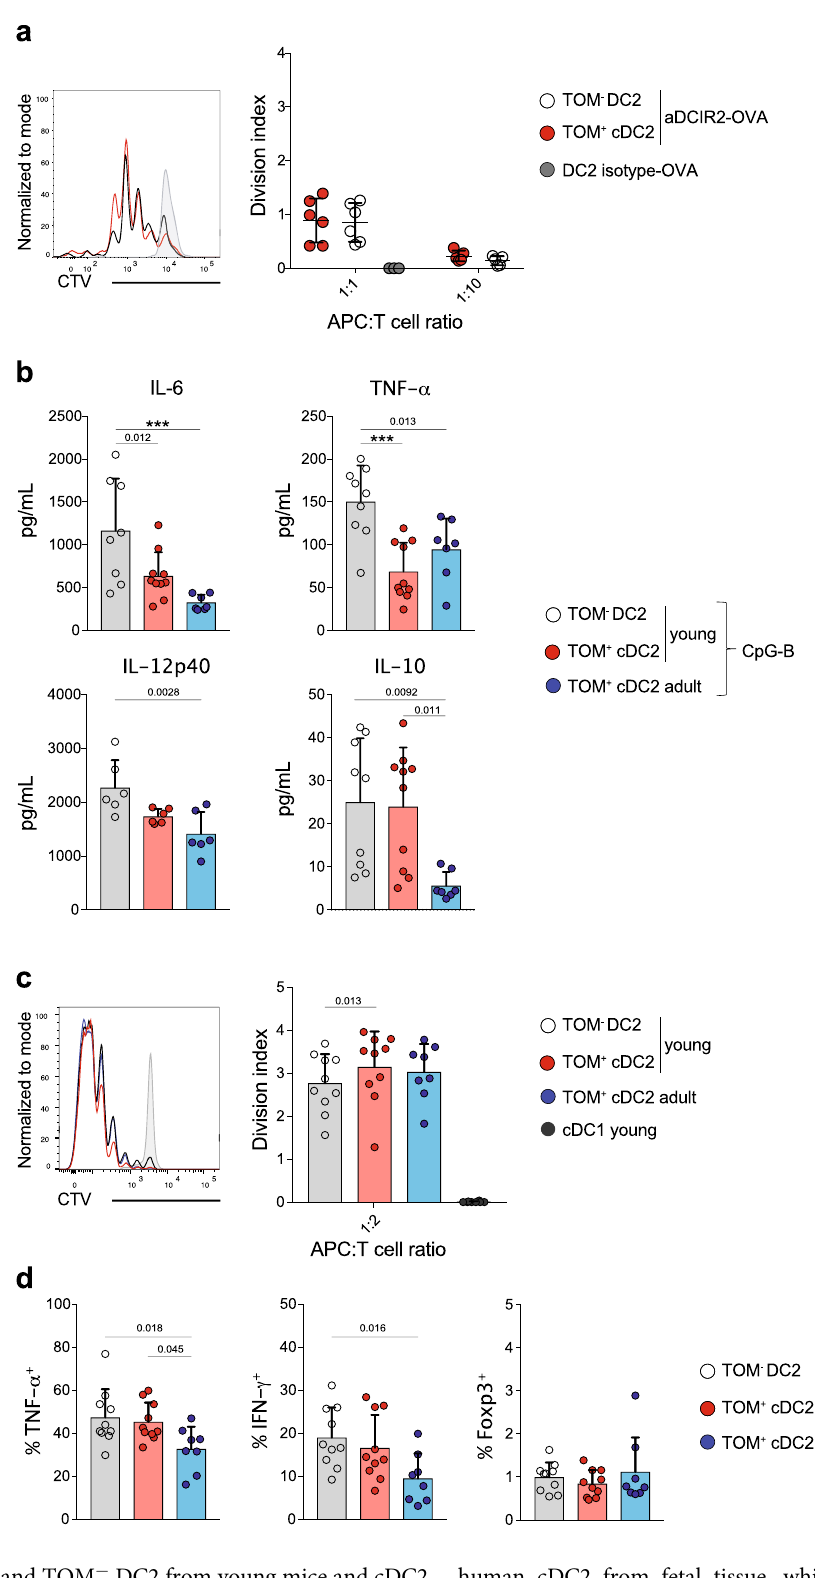
human cDC2 from fetal tissue, which suppress T-cell-derived TNF- α through ARGINASE 2 43 . T cells stimulated with TOM − DC2 from young mice also produced more IFN- γ than T cells stimulated with cDC2 from adult mice (Fig. 6d and Supplemen- tary Fig. 7B). Increased IFN- γ production was also observed for T cells stimulated with TOM + cDC2 from young mice compared to cDC2 from adults (Fig. 6d and Supplementary Fig.